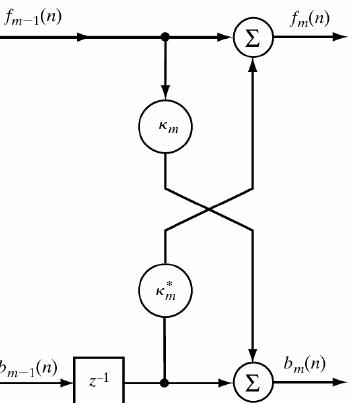
Figure 3. Lattice filter prediction cascade